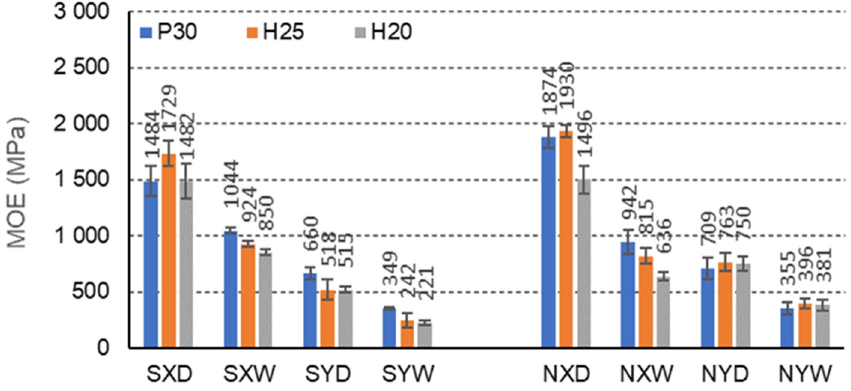
Figure 11. Illustration of the MOE relationship of honeycomb panels with an E ‐ cell core. Whiskers represent standard deviations.